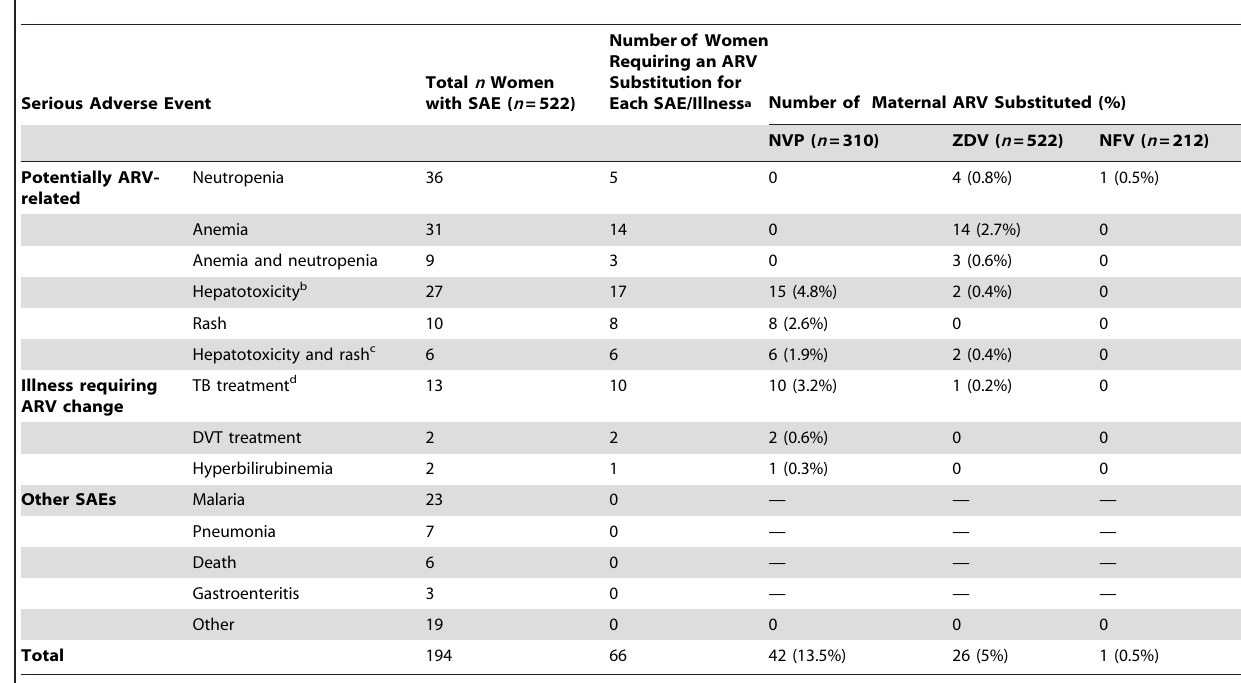
Table 5. Maternal SAEs during intervention period (enrollment to 9 mo post partum), number resulting in ARV substitution, and proportion of women initiated on ARV who required